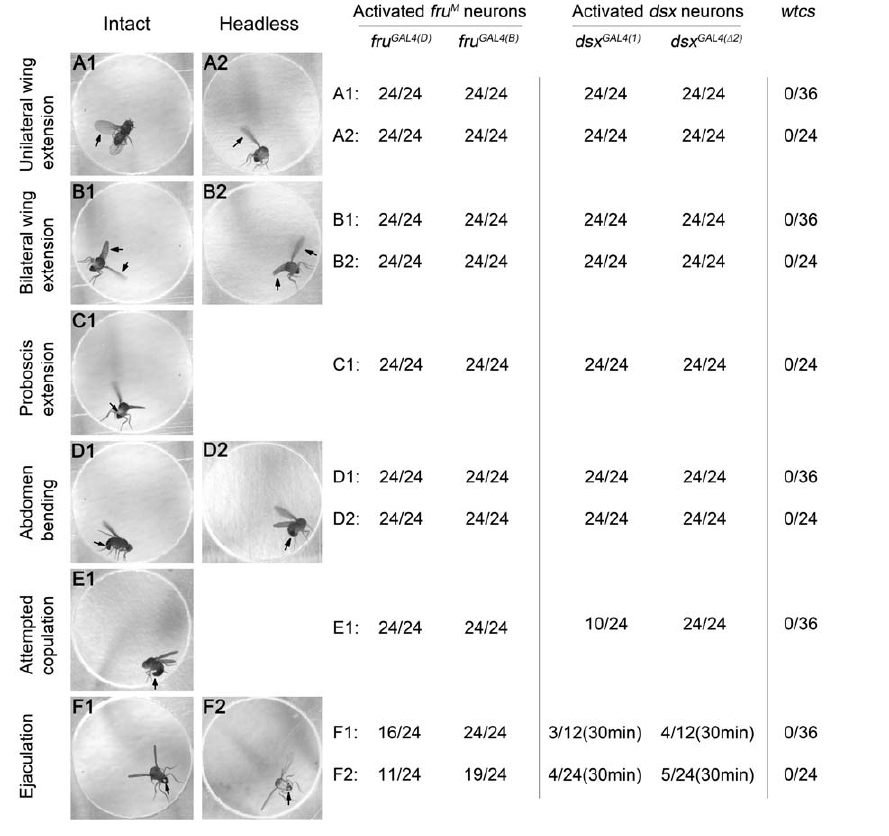
Figure 1. Activation of all fru M or all dsx neurons triggers almost all steps of male courtship rituals. (A–F) Video stills of an intact male (A1–F1) or headless male (A2–F2) expressing dTrpA1 under fru GAL4(B) control. Videos were taken at 29 u C. All late steps of male courtship behavior can be induced in such condition, including wing extension (A1–2 for unilateral wing extension and B1–2 for bilateral wing extension), proboscis extension (C1; not in headless males), abdomen bending (D1–2), attempted copulation (E1; not found in headless males) and ejaculation (F1–2). The distinction between abdomen bending and attempted copulation is that the latter is a momentary thrusting action during which a male fully curls its abdomen. These behaviors can also be elicited in solitary males by activating all dsx neurons. The right panel indicates the fraction of males tested that show the indicated behavior in 15 min after a shift from 22 u C to 29 u C. Control wild-type males did not display any courtship-like behavior in the observation